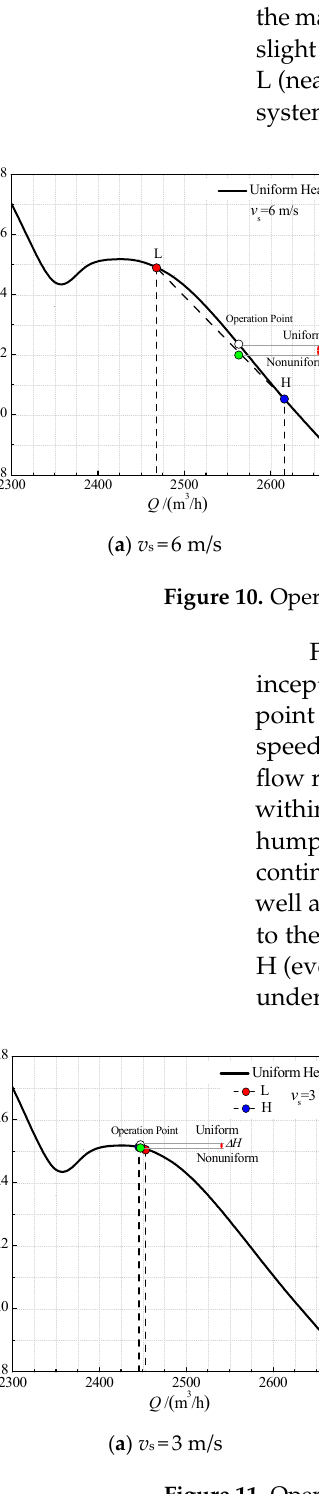
Figure 11. Operating point comparison between tube L and H, at full stall condition. According to the above analyzing of operation points of waterjet pump and its tubes under various ship speeds, stall behaviors under nonuniform inflow can be divided into partial deep stall, partial stall, stall inception and full stall. Namely, nonuniform inflow gives rise to partial stall in the tube, resulting in flow instability of the whole parallel pump system although its total flow rate under uniform inflow is far away from instability lim- iting line. 5. Discussion 5.1. Correlation between Multi-Segment Head Curve and Stall Behavior under Nonuniform Inflow Operating points of tube L and H also have a dominant effect on variations of head curve at four different stall conditions, and consequently can exhibit a multi-segment head curve instead of the traditional parabolic curve in Figure 12. In order to explore its gener- ation mechanism, the following analysis is focused on the change rule of each segment head curve and its corresponding stall behavior in the established parallel pump system.